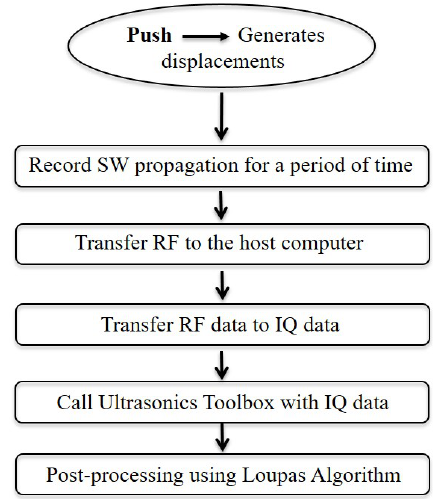
Figure 4. Schematic flowchart used for postprocessing IQ